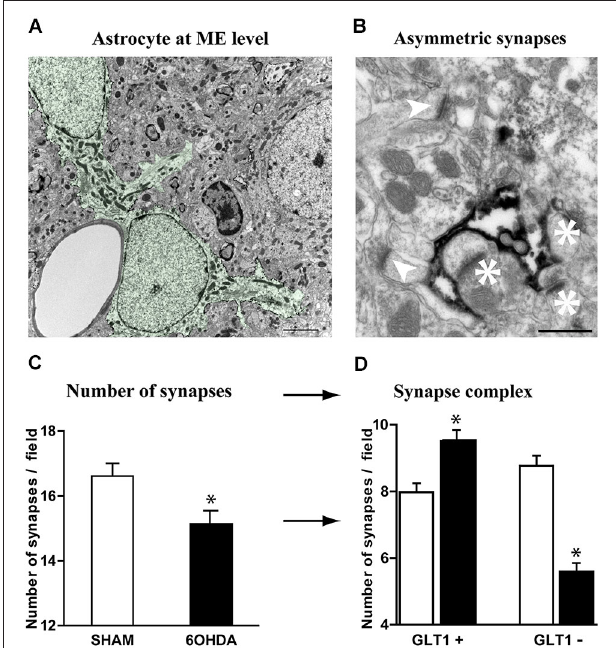
FIGURE 4 | Astrocytes further contacts asymmetric striatal synapses after dopamine depletion. (A) Electron micrograph of GLT1 immunolabeled striatal astrocytes colored in green (pseudocolor image NHI Image J) (scale bar = 2 µ m). (B) GLT1-positive astrocytic processes surrounding (asterisk) or not surrounding asymmetric striatal synapses (arrowhead) (scale bar = 0.5 µ m). (C) A significant decrease in the number of asymmetric synapses is observed in 6-OHDA rat striatum compared with control ( n = 4 animals per group; Student t -test; p < 0.05). (D) Such decrease however decomposes in a significant increase in GLT1+ asymmetric synapses and a dramatic decrease in the number of GLT1 − asymmetric synapses in the 6-OHDA rat compared to controls ( n = 4 animals per group; one-way ANOVA followed by Bonferroni; p <